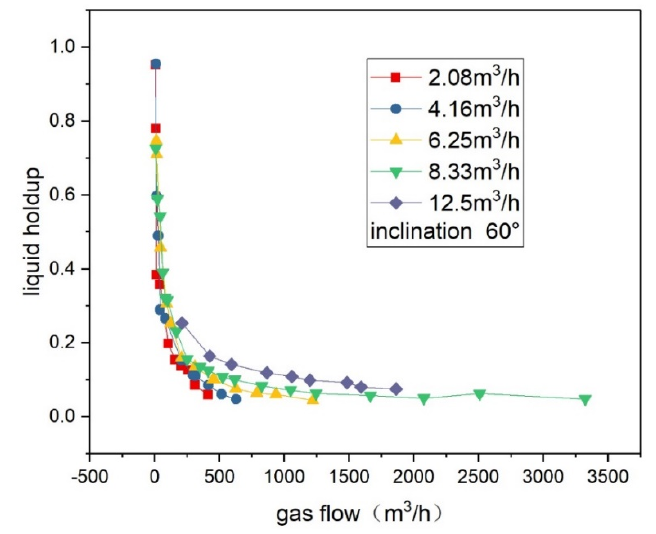
Figure 11. Variation of liquid holdup with gas flow rates under different liquid volumes at an inclination angle of 60°.